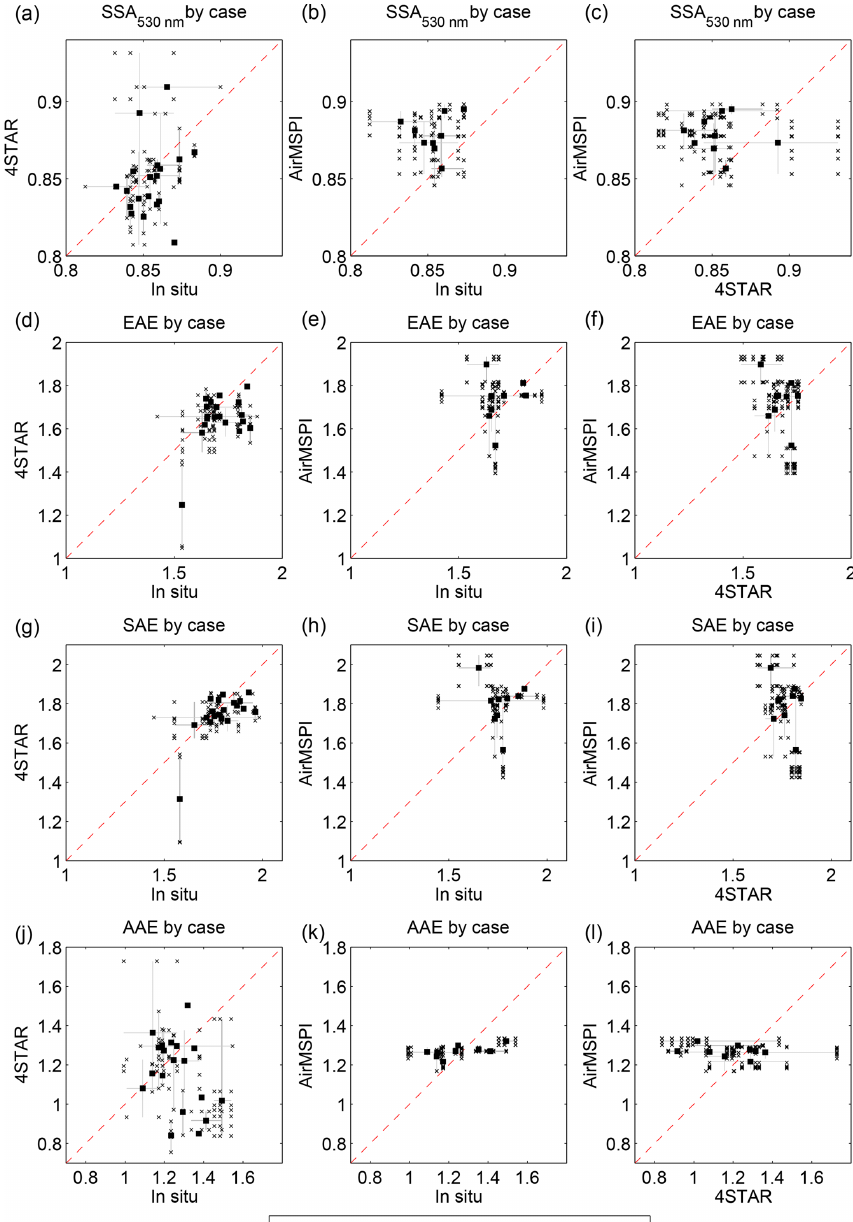
Figure 8. (Top row) SSA 530nm , (second row) EAE, (third row) SAE, and (bottom row) AAE for (left column) 4STAR versus in situ measurements (middle column) AirMSPI versus in situ measurements, and (right column) AirMSPI versus 4STAR measurements, for all comparison cases with valid coincident observations. All individual retrievals are shown by grey × marks; for cases with multiple retrievals from a single instrument, the average value and range for a given case is shown by a black circle with